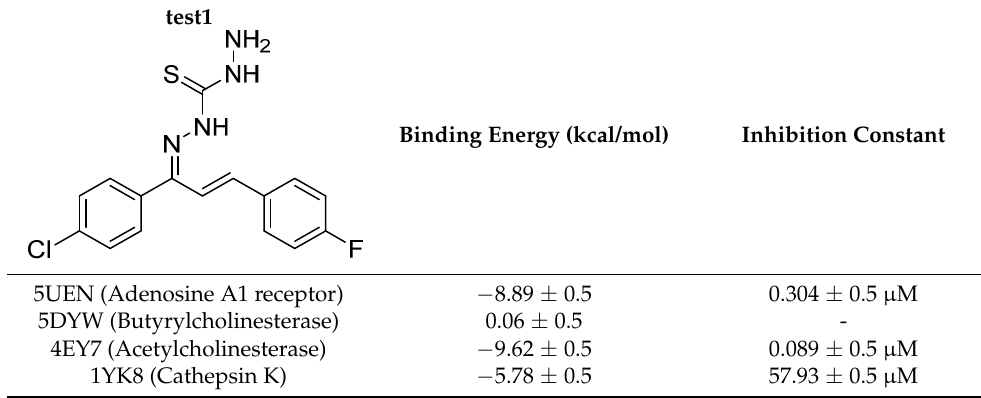
Table 8. Molecular binding results of compound test2 with four macromolecules.